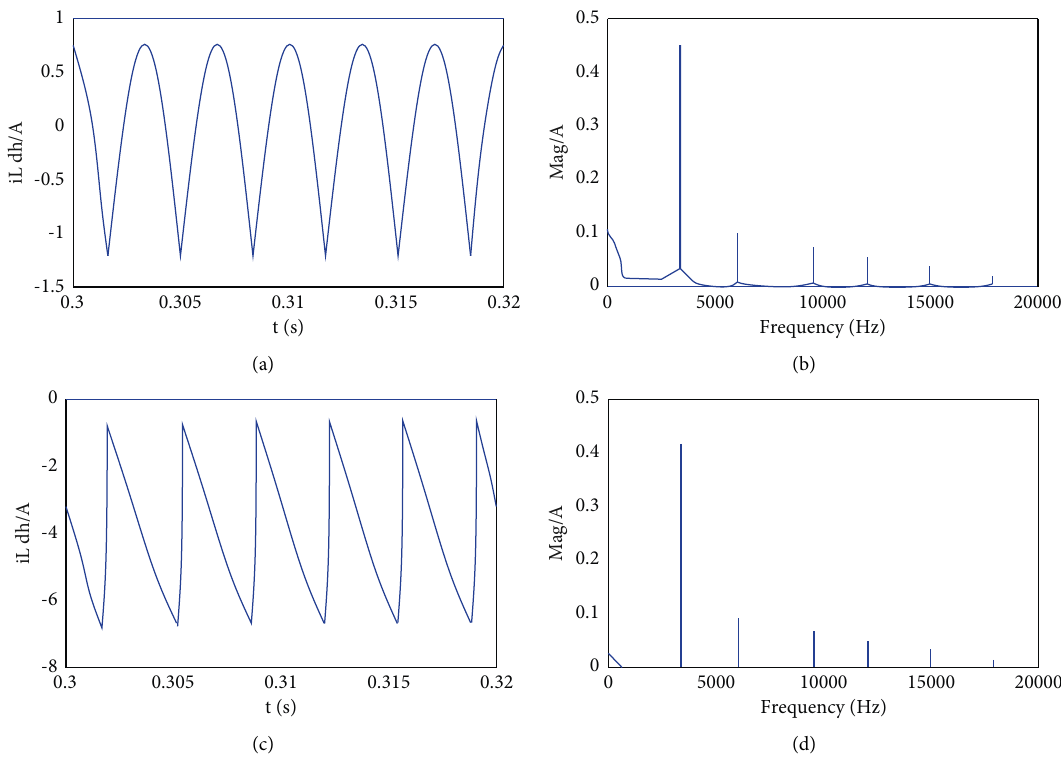
Figure 5: Typical nonlinear load current waveform and spectrum. (a) Typical nonlinear load d -axis harmonic current waveform. (b) Typical nonlinear load d -axis harmonic current spectrum. (c) Typical nonlinear load q -axis harmonic current waveform. (d) Typical nonlinear load q -axis harmonic current